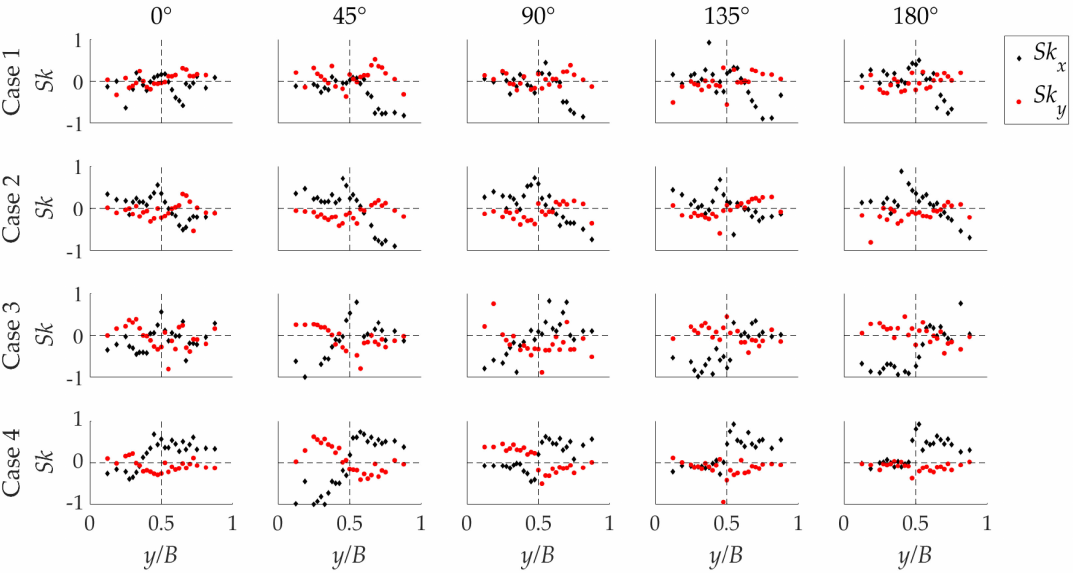
Figure 11. Lateral distribution of skewness coefficients of the longitudinal and lateral velocity fluctuating velocities from Case1 to Case